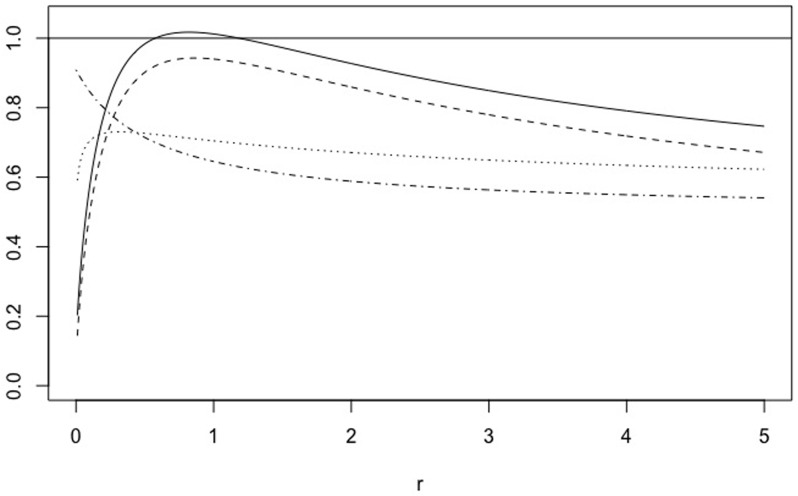
Family YA, r.CEN, MCEN, ACC* and MCC* as function of r for A = 10.